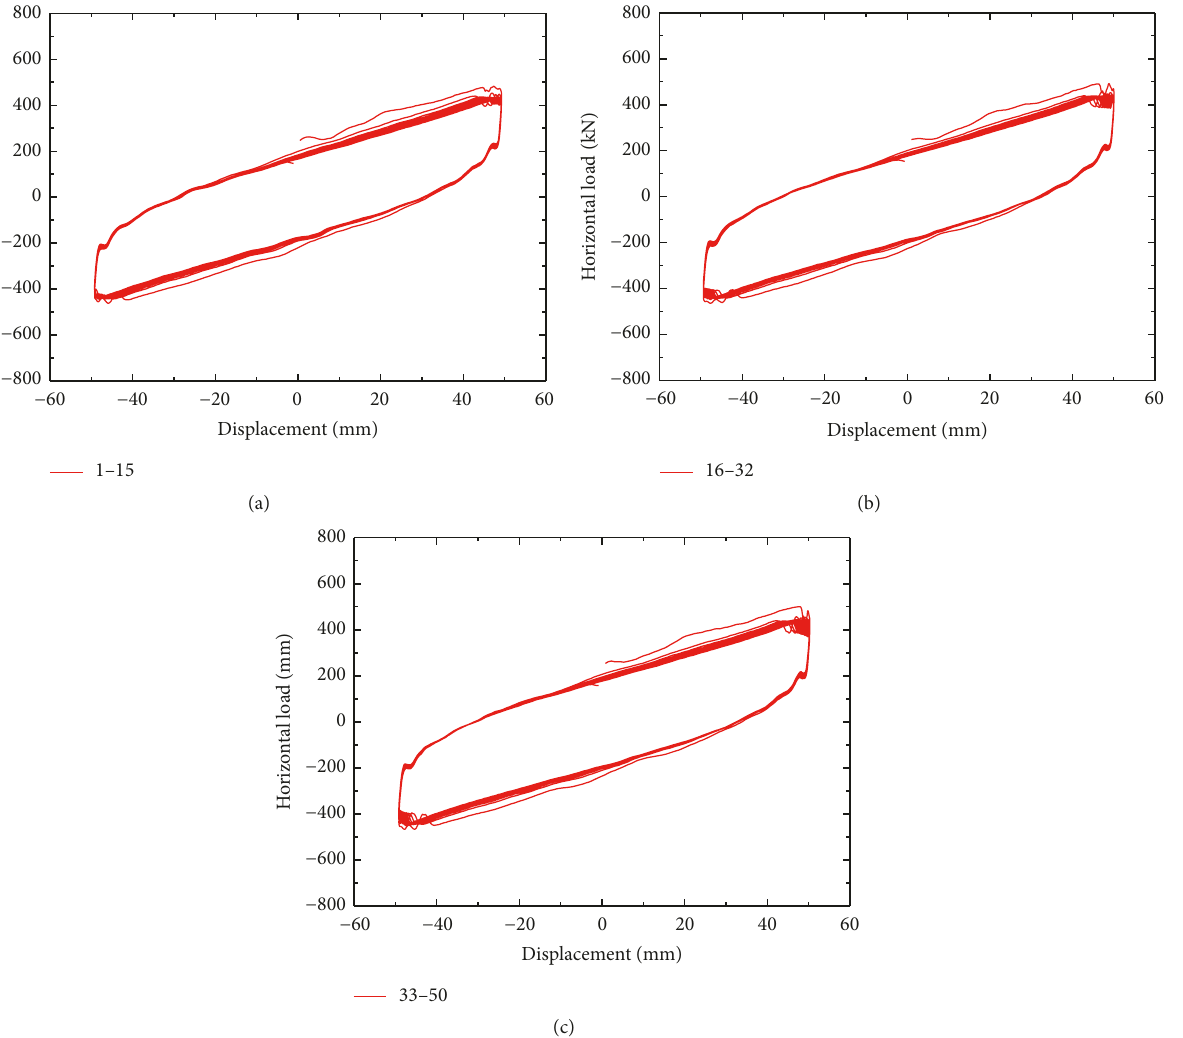
Figure 12: Curves of loading time correlation test: (a) 1–15, (b) 16–32, and (c) 33–50.